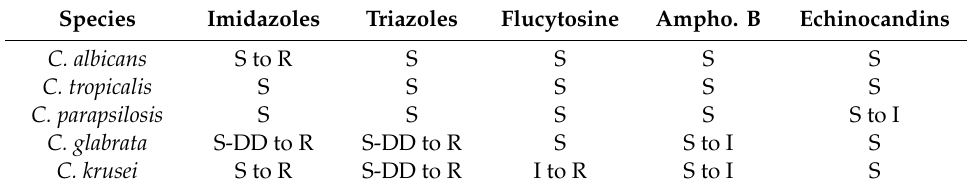
Table 1. General susceptibility patterns of Candida species to antifungal drugs used in the treatment of candidiasis (adapted from [21,22]). S—susceptible; S-DD—susceptible dose-dependent; I—intermediate;